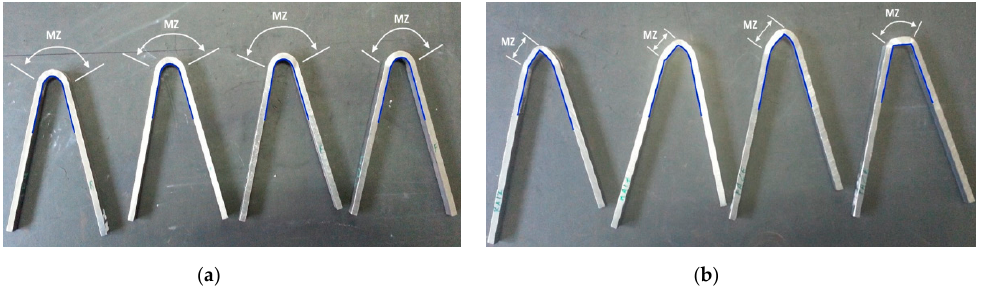
Figure 12. Bending tests corresponding to samples ( a ) P_APP_T08 and ( b ) P_APP_T00.